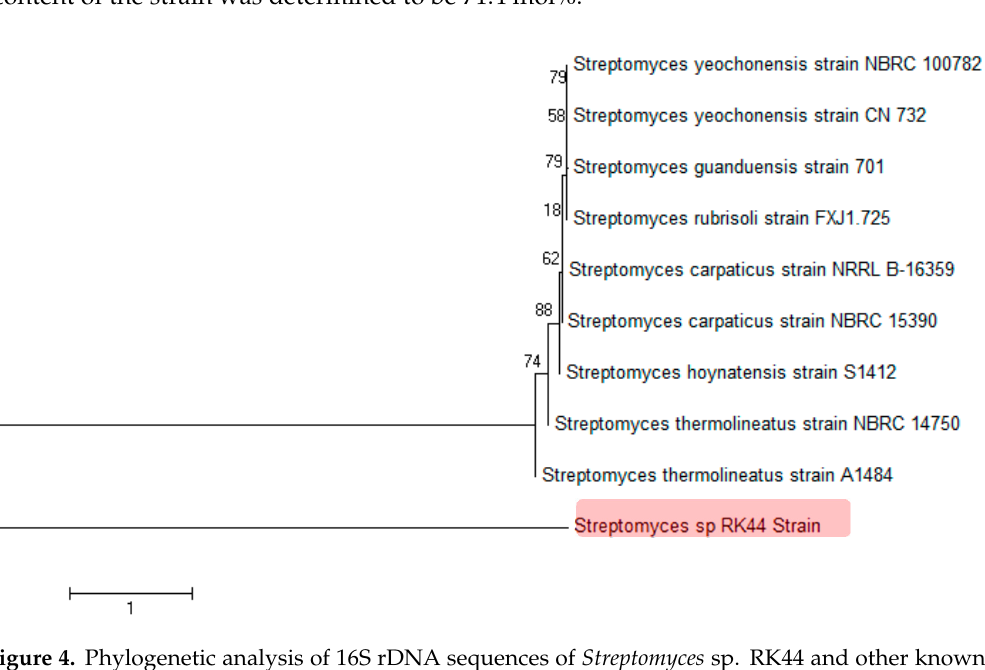
Figure 4. Phylogenetic analysis of 16S rDNA sequences of Streptomyces sp. RK44 and other known Streptomyces species, indicating that Streptomyces sp. RK44 is a new Streptomyces species.